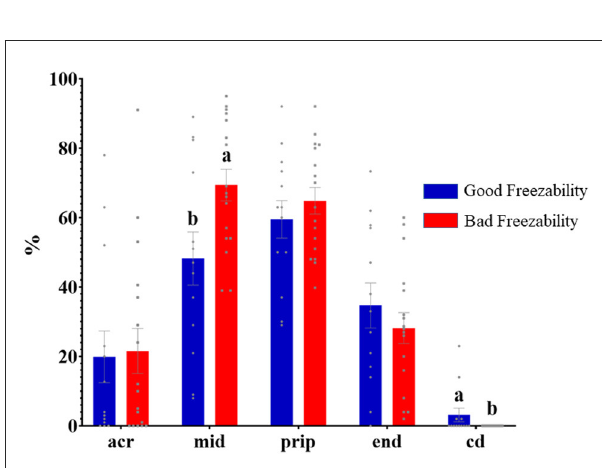
FIGURE2 Proportion (mean ± SEM) of freshly ejaculated spermatozoa retrieved from ejaculates classified as good (GFE) or poor freezability (PFE), with representative localization patterns of AQP3 in membrane domains. Acr, Acrosome; mid, midpiece; prip, principal piece; end, end piece; cd, cytoplasmic droplet. Different letters (a, b) indicate significant differences ( P < 0.05) between groups.